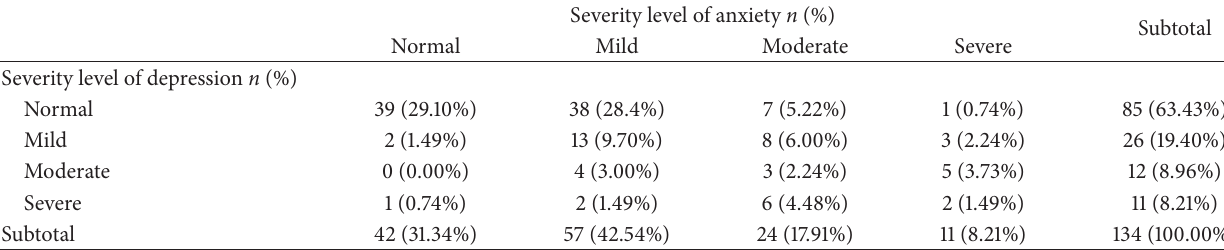
Table 2: Coexistence of anxiety and depression (𝑁 = 134)